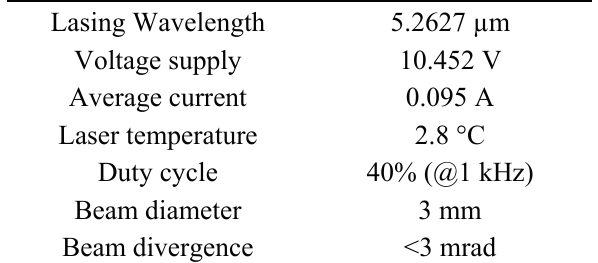
Table 2. Example of the QCL operating